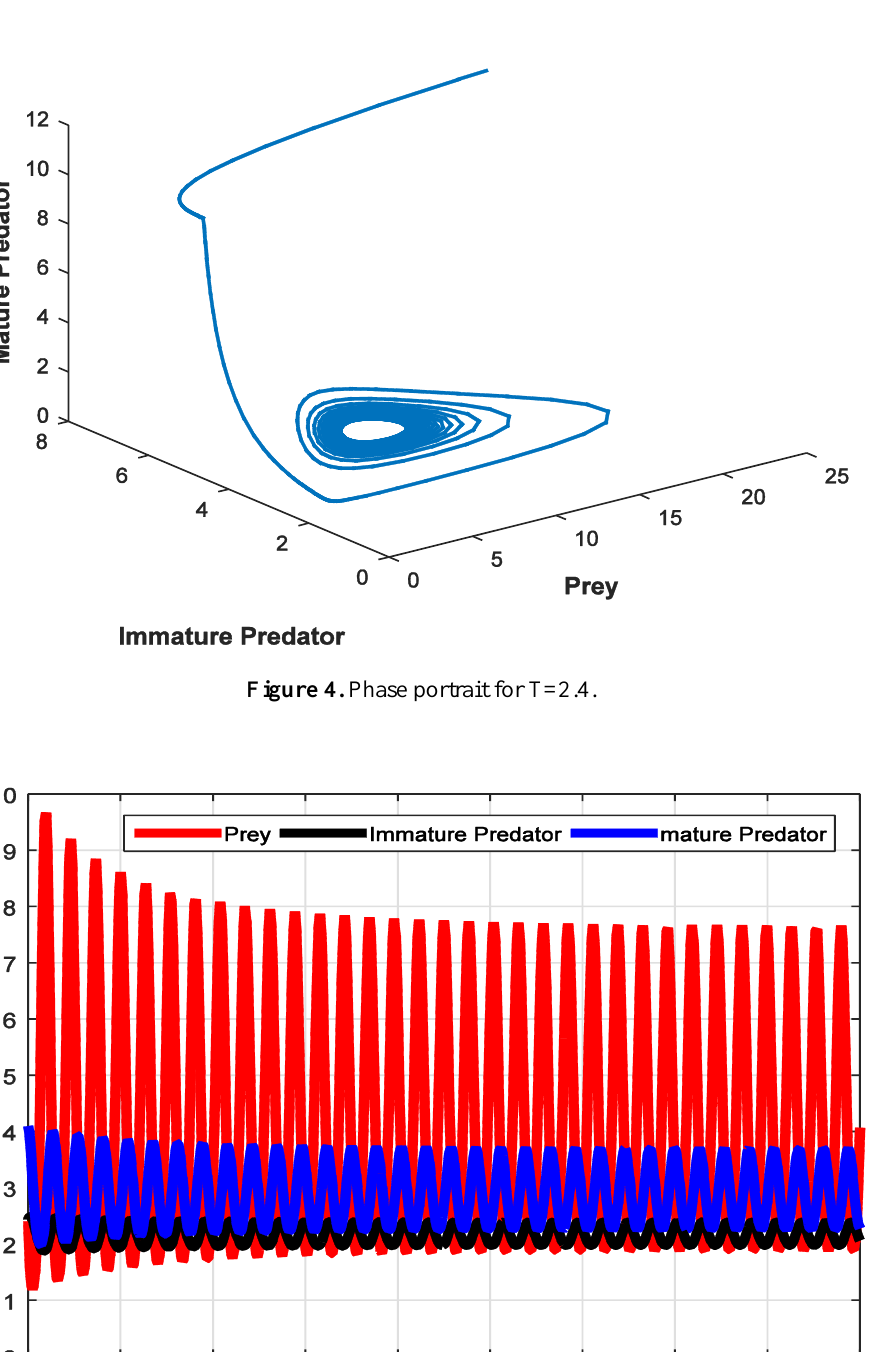
516 | Vol. 7, No. 4, 2022